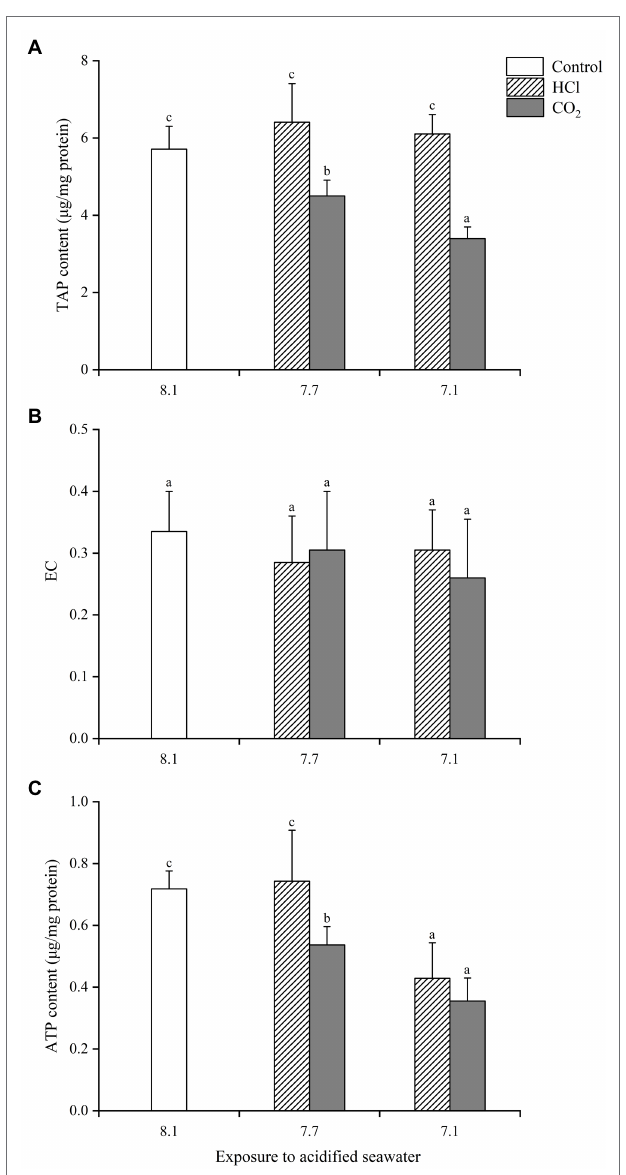
FIGURE 3 | Effects of seawater acidification induced by HCl addition and CO 2 enrichment on TAP content (A) , EC (B) and ATP content (C) in hemocytes of M. edulis . Data were expressed as means ± SD ( n = 6). Different letters represent significant differences among experimental groups ( p < 0.05).